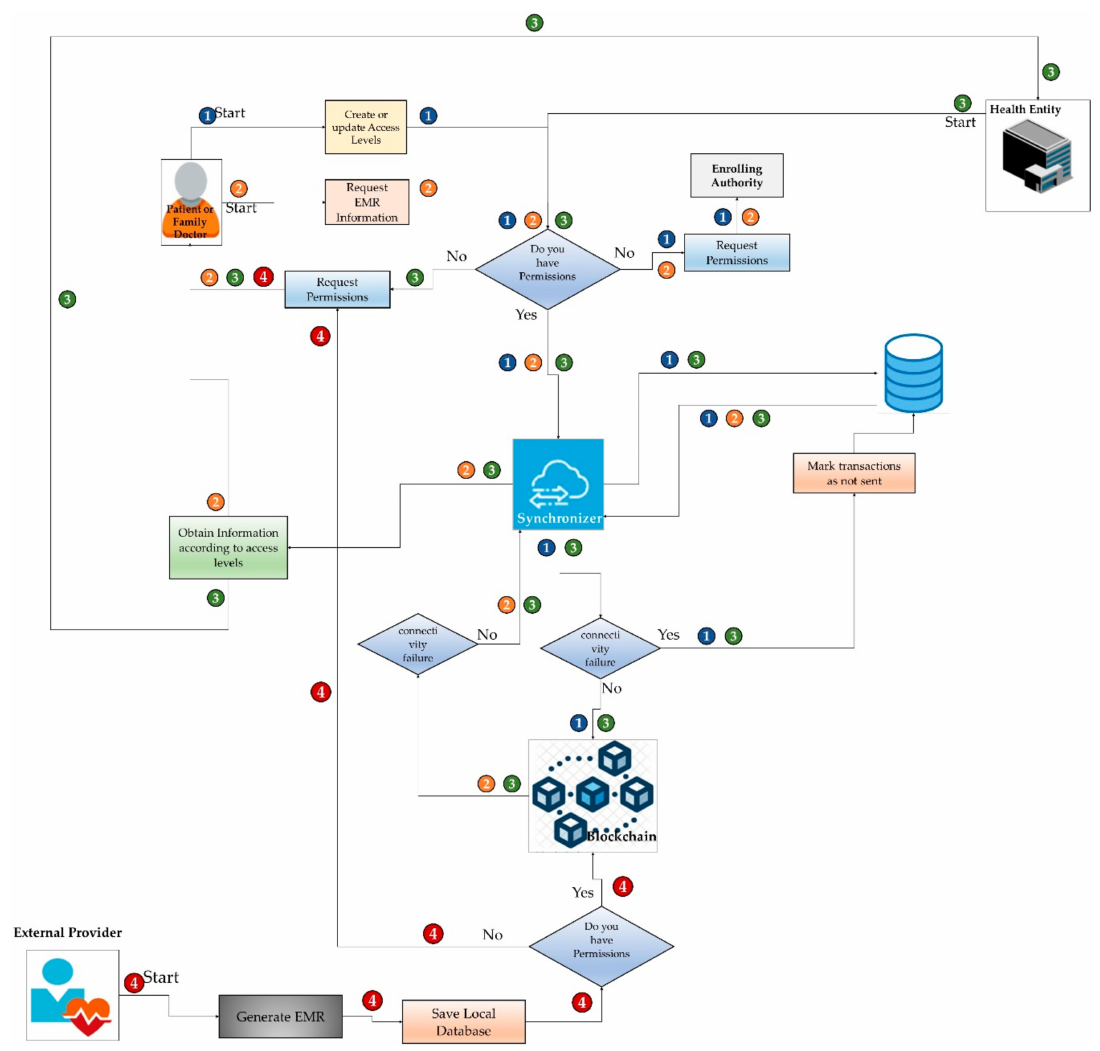
Figure 3. Interaction cases of the di ff erent